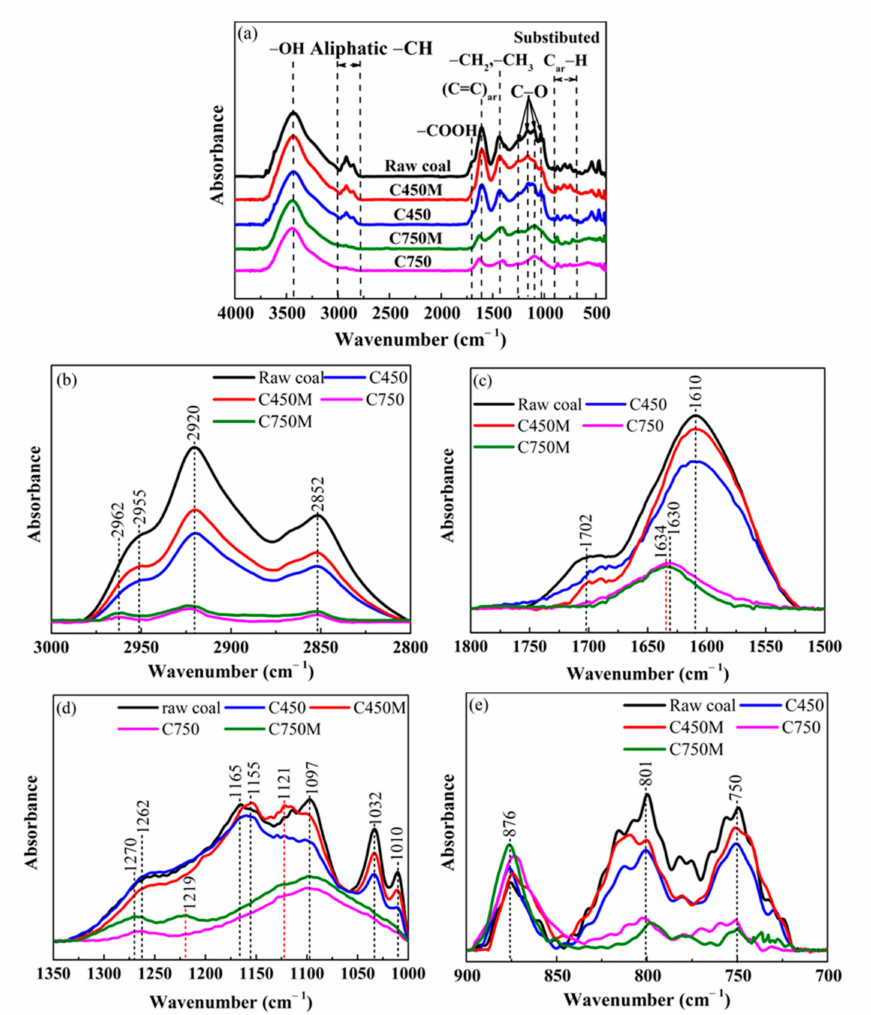
Figure 3. FTIR spectra of raw coal and four semi-cokes: ( a ) FTIR spectra from the 4000–400 cm − 1 zone; ( b ) FTIR spectra after subtracting the baseline from the 3000–2800 cm − 1 zone; ( c ) FTIR spectra after subtracting the baseline from the 1800–1500 cm − 1 zone; ( d ) FTIR spectra after subtracting the baseline from the 1350–1000 cm − 1 zone; ( e ) FTIR spectra after subtracting the baseline from the 900–700 cm − 1